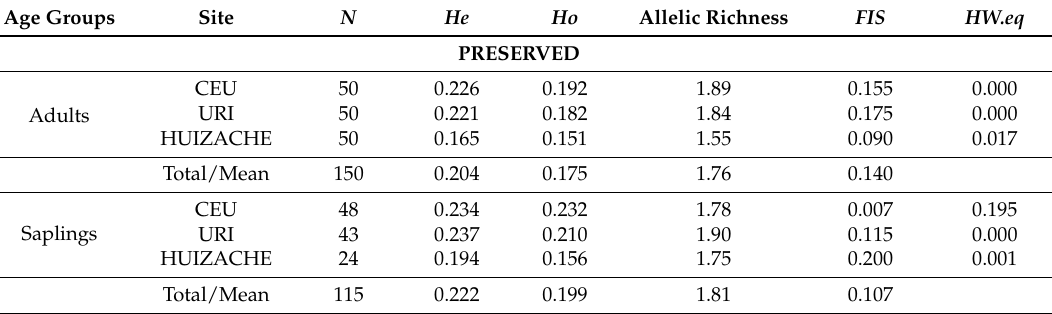
Figure 2. Maps showing the three lagoon systems (left) and details of sampling sites (right), where: ( A ) CEU; ( B ) URI; and ( C ) HC. Satellite imagery was obtained from Google Earth. Table 1. Genetic diversity and inbreeding coefficients from twelve subpopulations of Avicennia germinans , where: He , expected heterozygosity; Ho , observed heterozygosity; allelic richness; FIS , inbreeding coefficient and HW.eq , Hardy ‐ Weinberg equilibrium.